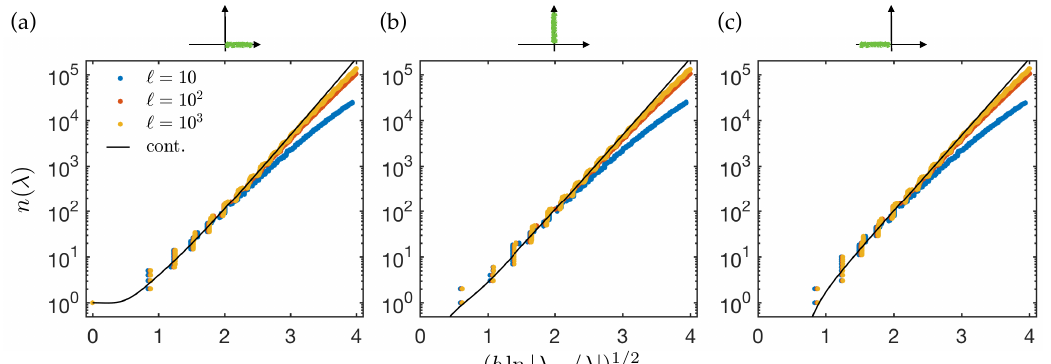
Figure 5: Spectrum of modulus of eigenvalues of ρ T A for bipartite geometry along the real and imaginary axes. The total system size is L = 2 (cid:96) for each (cid:96) . Solid lines are the prediction in Eq. (85b). Dots are numerics, with different colors corresponding to different subsystem sizes. A numerical procedure similar to that of Fig. 3 is used to obtain few thousand largest (in modulus) many-body eigenvalues from a truncated set of single particle